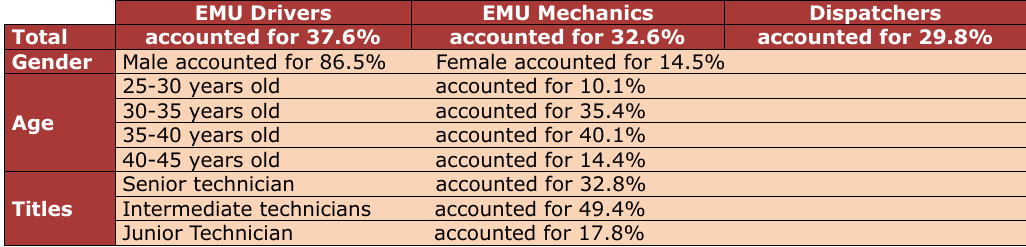
Table 2. Specific statistical characteristics of